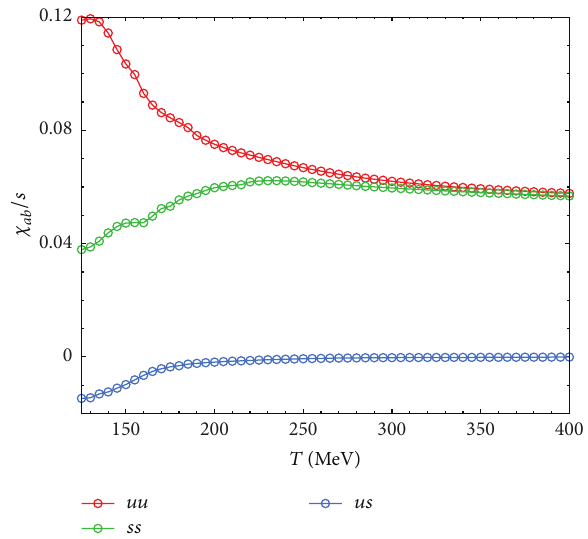
Figure 8: The charge fluctuations as functions of temperature in the lattice gauge theory [31, 32]. Results at temperatures < 160MeV are likely belonging to hadronic state. At higher temperatures, the system is characterized by partonic degrees of freedom. The graph is taken from